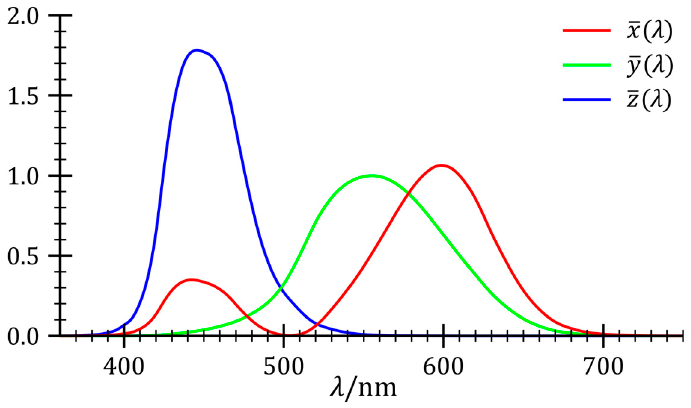
Figure 3. CIE colour matching functions 1932 2°. Reproduced with permission from [42], copyright 2007, Wiley.